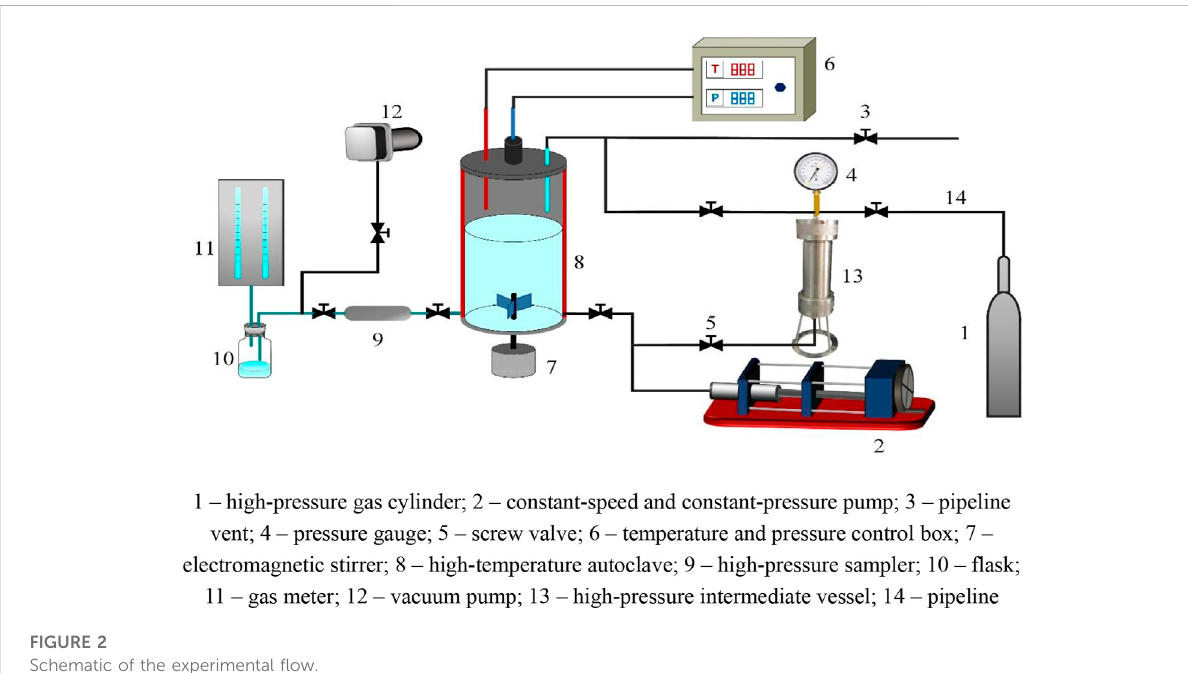
FIGURE 2 Schematic of the experimental fl